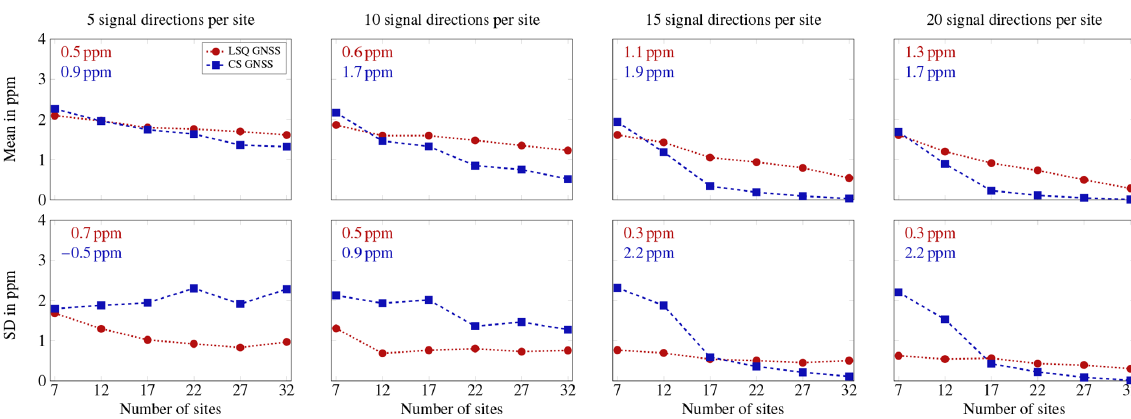
Figure 4. Averaged over all voxels, this figure shows the mean of the absolute difference and the standard deviation (SD) of the difference between estimated refractivities and WRF refractivities in ppm, deduced from 48 samples of each investigated observing geometry setting composed of a certain number of synthetic GNSS sites and various numbers of signal directions per site. The dashed and dotted lines serve for better following the variation of the represented quantities with the number of sites, but only the discrete values indicated by the markers should be evaluated. The legend in the upper left subplot holds for all the subplots. In each subplot, the improvement by introducing 32 sites instead of 7 sites is given in red and blue. Degradations are given with a minus